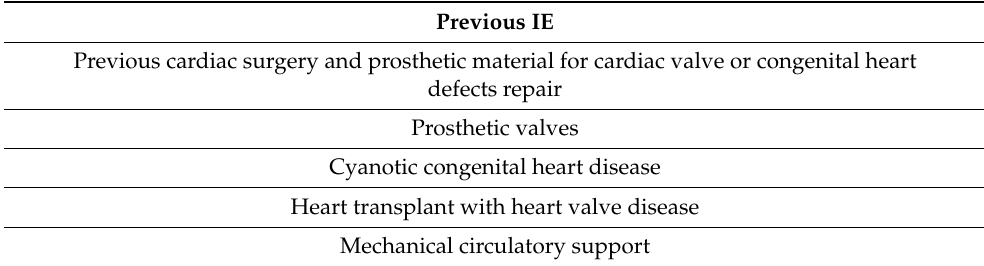
Table 8. Current indications for antibiotic prophylaxis to prevent infective endocarditis